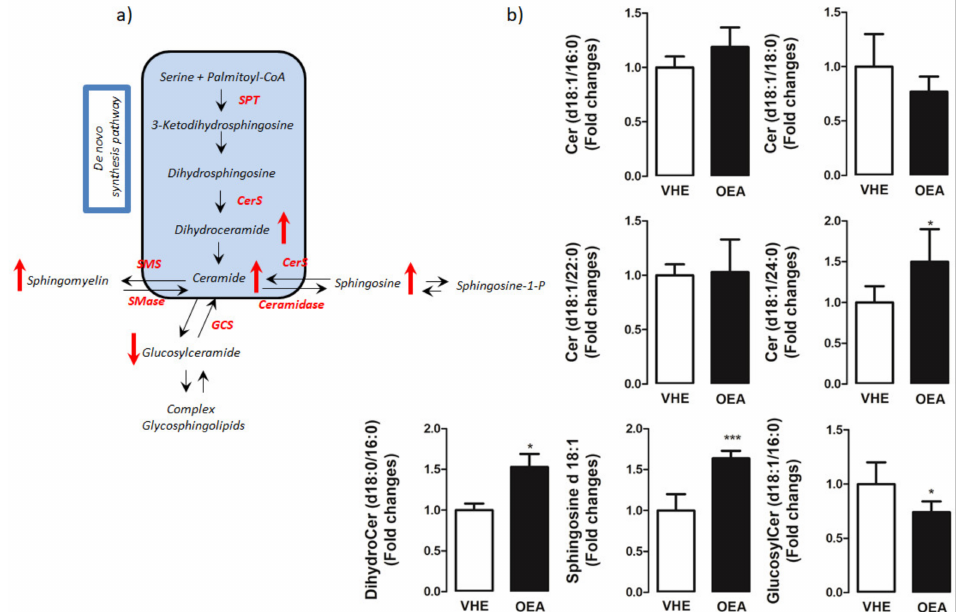
Figure 3. Hepatic sphingolipid analysis by LC-MS/MS. ( a ) Schematic representation of the sphingolipid pathway. De novo sphingolipid synthesis starts with the condensation of serine and palmitoyl-CoA by the rate-limiting enzyme, serine palmitoyltransferase (SPT) to 3-keto-dihydrosphingosine. Following further modification to dihydrosphingosine, ceramide synthases (CerS) convert dihydrosphingosine to dihydroceramide which is then desaturated to generate ceramides. Ceramides can be glycosylated by glucosylceramide synthase (GCS) to glucosylceramides which can serve as an intermediary for other glycosphingolipids, used as a substrate for sphingomyelin synthesis by sphingomyelin synthase (SMS) or deacylated by ceramidases to form sphingosine and subsequently, through the action of sphingosine kinases generate sphingosine-1- phosphate. ( b ) Distribution of sphingolipid species in the liver. In the figure, the mean ± SEM of values obtained from five different samples is reported; *** p < 0.001; * p < 0.05. Red arrows indicated metabolites that are up and down-regulated in OEA vs. VHE